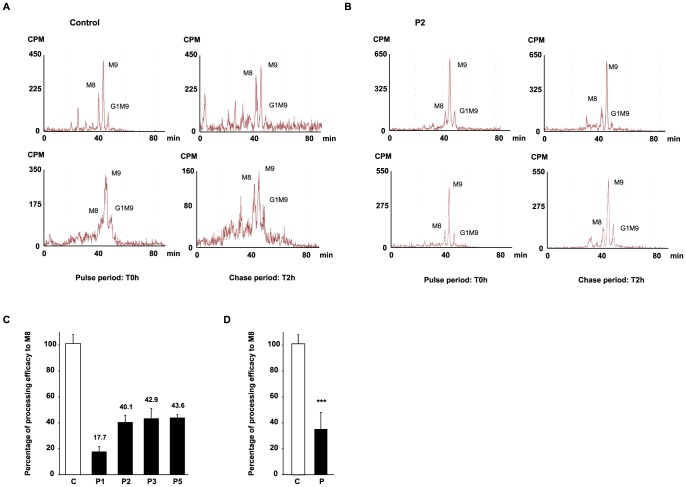
HPLC analysis of N-linked oligosaccharides from control and patient's fibroblasts reveal a delay of trimming from Man9GlcNAc2 to Man8GlcNAc2 in MAN1B1-deficient patients.Protein N-linked oligosaccharides of two different control (A) and one MAN1B1-deficient individuals (P2, B) were separated by HPLC after the pulse period (left panels) and 2 hours of chase (right panels). Depicted for both controls and P2 are two representative chromatograms from two independent experiments, with one set of experiments presented in the upper panel, and a second one in the lower panel. Symbols: M8, M9 indicate oligosaccharide species with 8 or 9 mannose residues and possessing two GlcNAc resides at their reducing ends. G1M9 indicates oligosaccharide species with 9 mannose and 1 Glc residues and possessing two GlcNAc residues at their reducing ends. (C) Relative peak areas of M8, M9, and G1M9 were quantified and the results expressed as the percentage of processing efficiency to M8. In the calculation, the trimming efficiency from M9 to M8, which corresponds to the difference between the percentage of M8 at T0 h and T2 h, was considered as 100%. The depicted values are the mean ± SEM of independent experiments. (D) Comparison of the mean processing efficacy of the three control cell lines (C) to the mean processing efficacy of all four MAN1B1-deficient cell lines (P). Data were analysed by using Student's t test. *** indicates a p value<0.001.